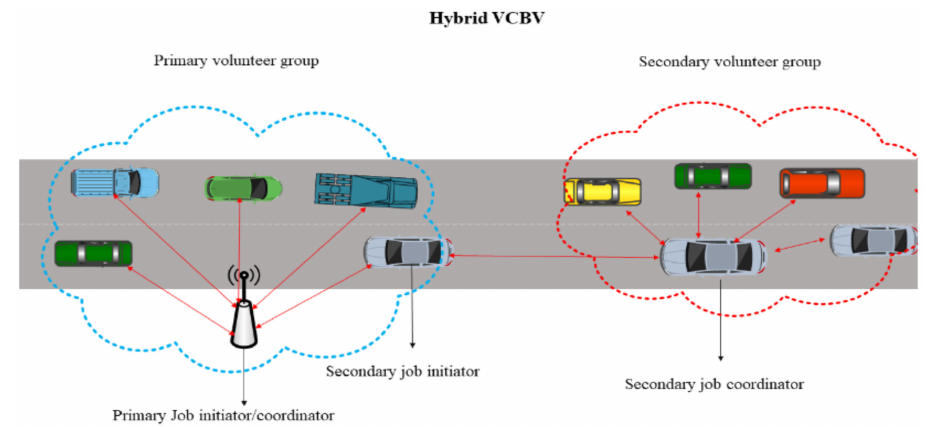
Figure 1. Hybrid VCBV.